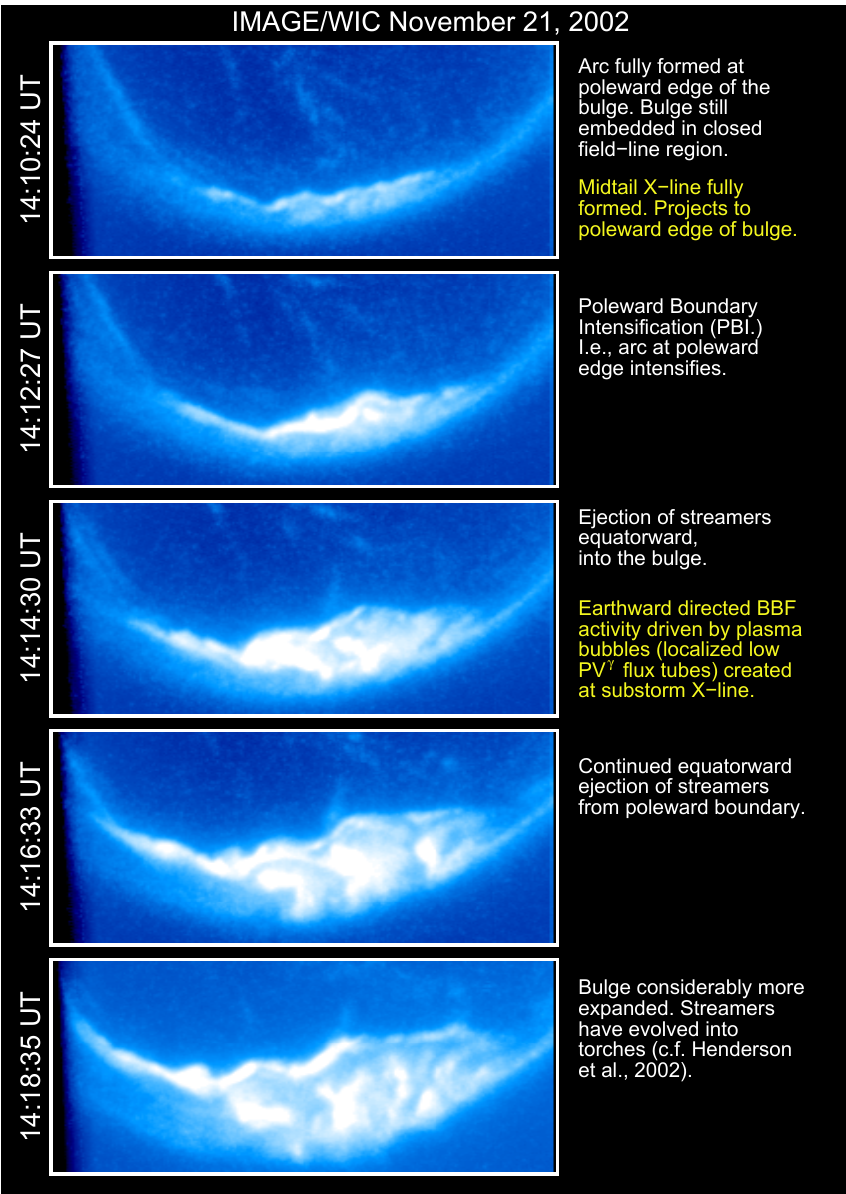
Fig. 3. Continuation of Fig. 2. Note that the images shown here are scaled differently than those in Fig. 2.